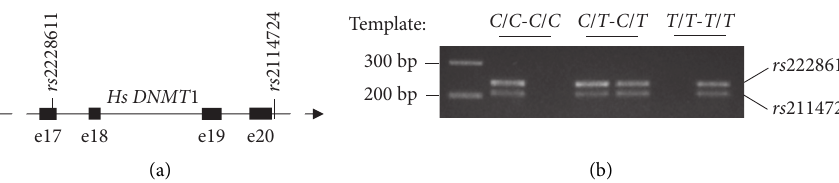
Figure 1: ARMS-PCR-based detection of minor and major alleles in controls and schizophrenia patients. (a) Location of the two loci in exon 17 (e17) and intron 20, respectively. (b) Validation of ARMS-PCR in distinctive identification of major and minor alleles at both